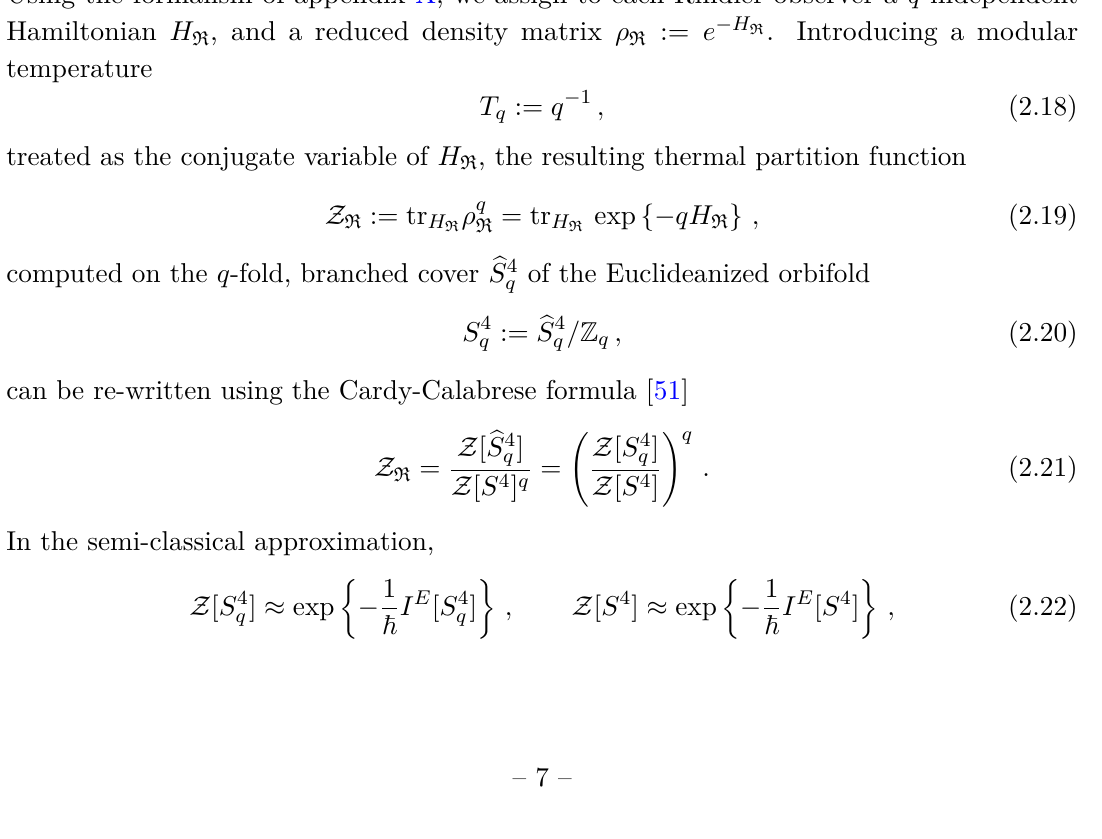
with radius ‘ = ‘/q . The set of fixed points Σ q q